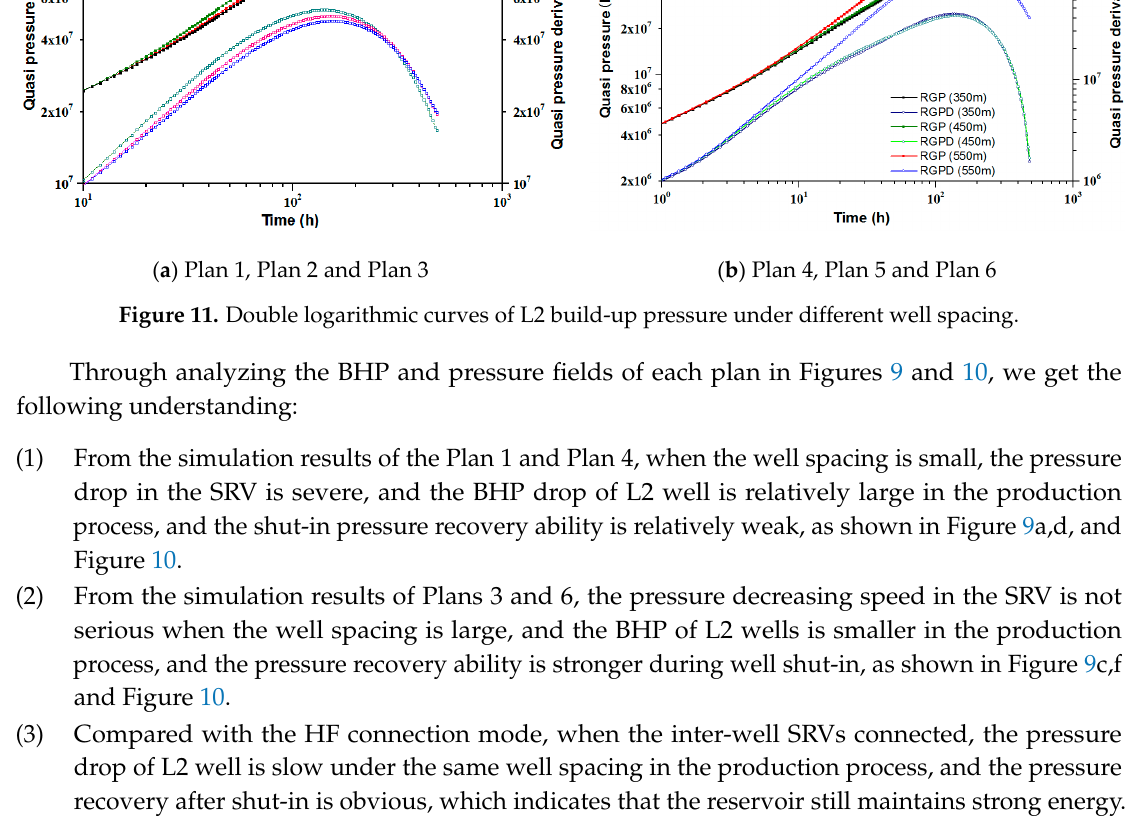
Table 3. IWMDs and basic physical properties of six plans.